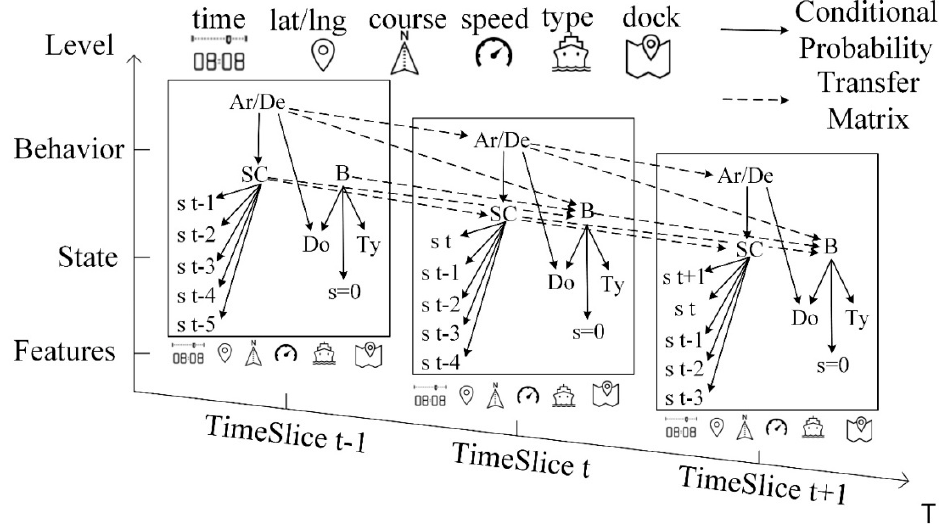
Figure 10. Dynamic Bayesian network when ship is in the dock.